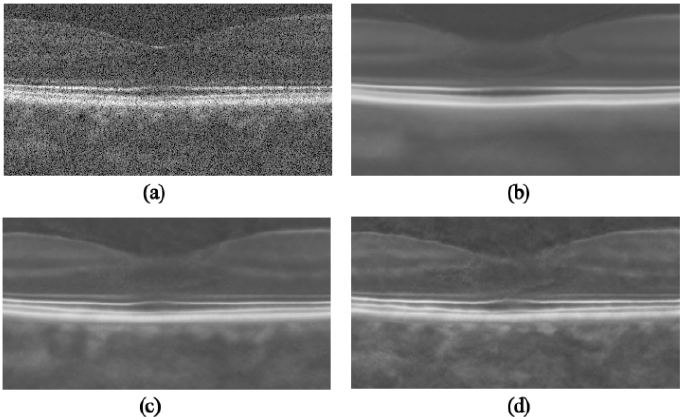
Figure 1. Comparison of DIP denoising OCT image: ( a ) input noisy image, ( b ) constructed image with DIP speckle reduction after 500 iterations, ( c ) constructed image with DIP speckle reduction after 1000 iterations, ( d ) constructed image with DIP speckle reduction after 1500 iterations.